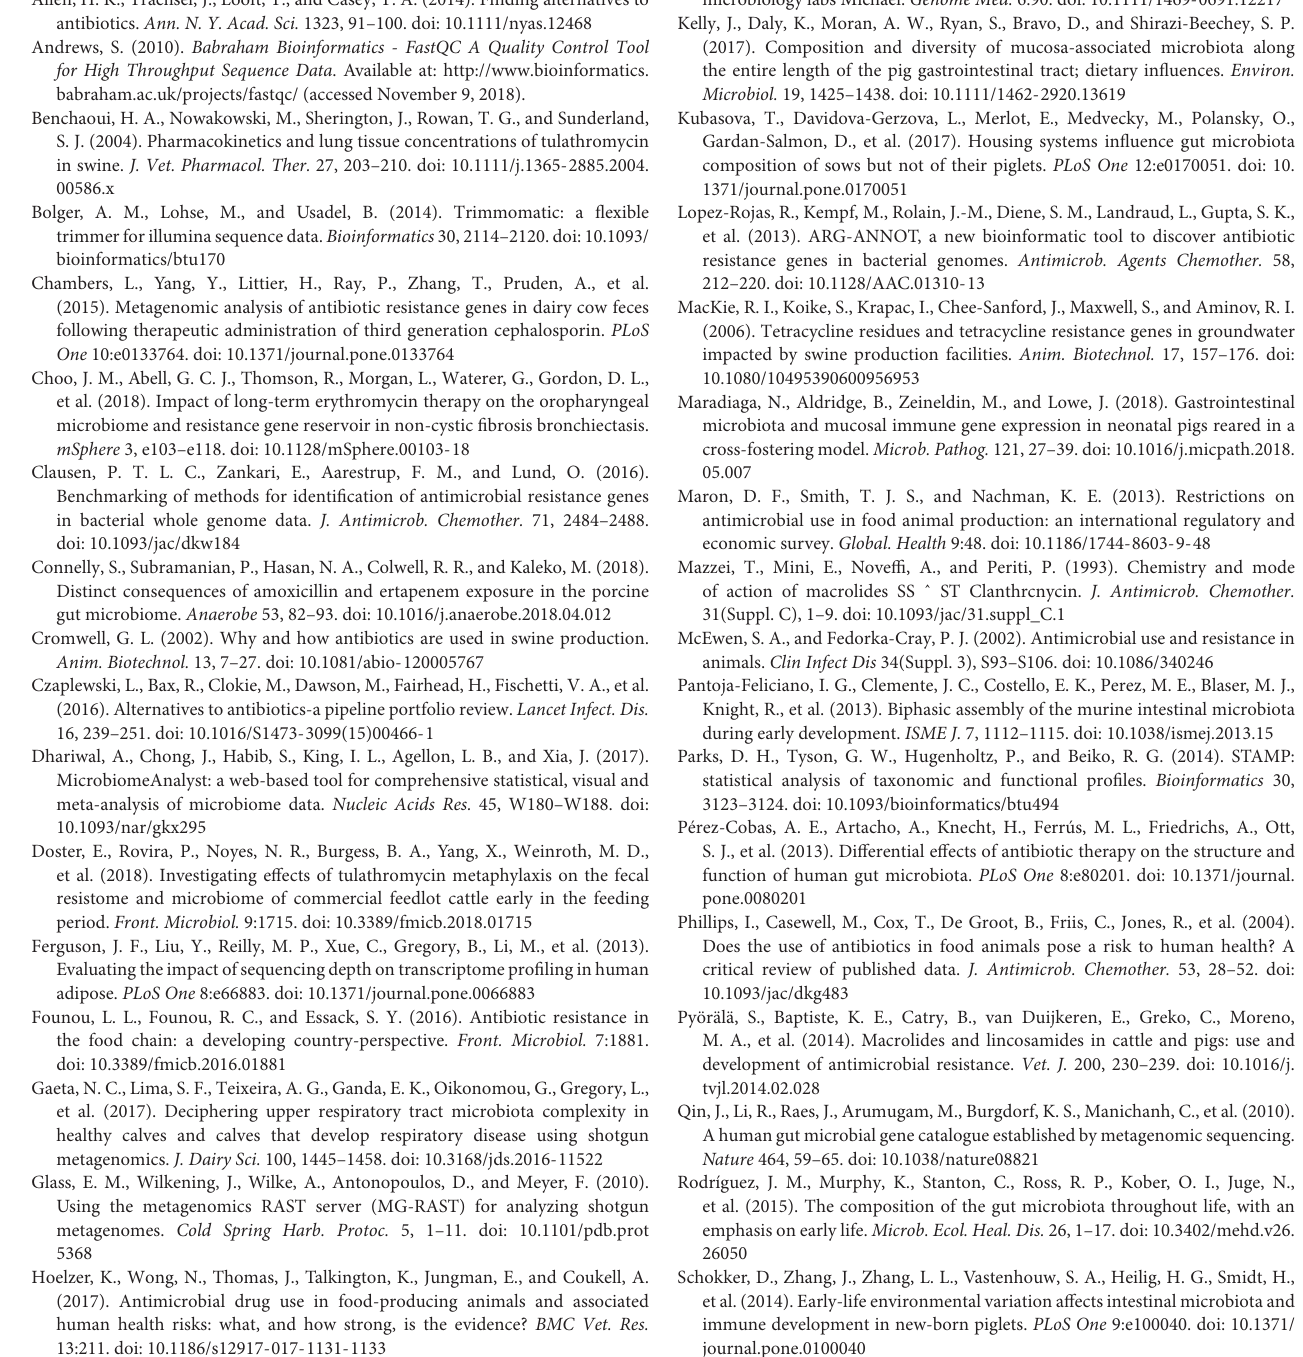
(TUL) groups. The yellow/blue color of the X axis of the heat map represent the degree of similarities and cluster between the related class of assessed parameters. FIGURE S6 | The difference in bacterial diversity indices (Chao 1, Shannon, Simpson and Pielou’s evenness indices) measures between the control (CONT)